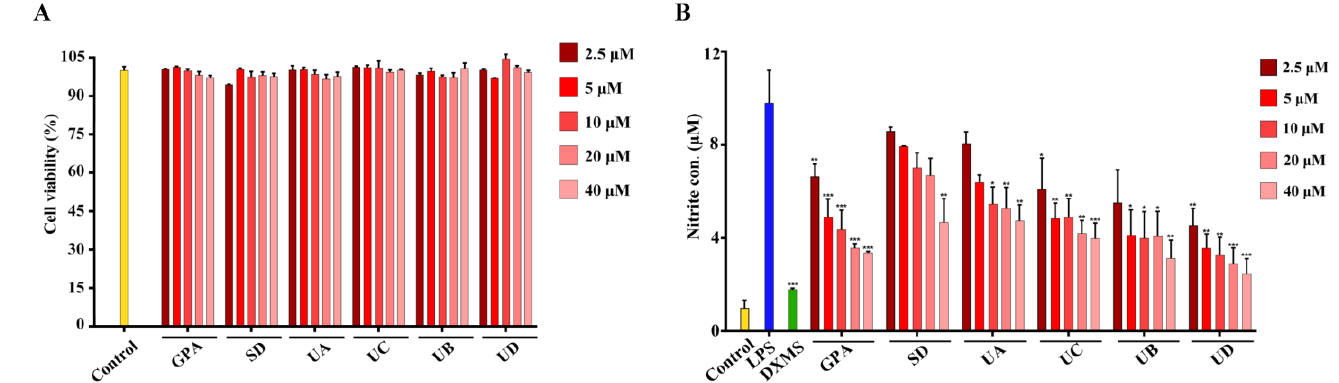
Figure 1. Cell viabilities of RAW 264.7 cells affected by six iridoid glucosides using cell counting kit-8 (CCK8) assay ( A ); The anti-inflammatory effects of the tested compounds on RAW 264.7 cells induced by lipopolysaccharide (LPS) by determining nitrite levels ( B ). * p < 0.05, ** p < 0.01, and *** p < 0.001 vs. LPS group ( n = 3). (GPA, geniposidic acid; SD, scyphiphin D; UA, ulmoidoside A; UC, ulmoidoside C; UB, ulmoidoside B; and UD, ulmoidoside D).